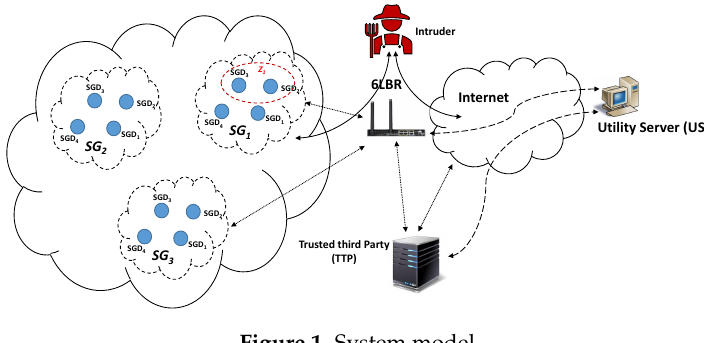
Figure 1. System